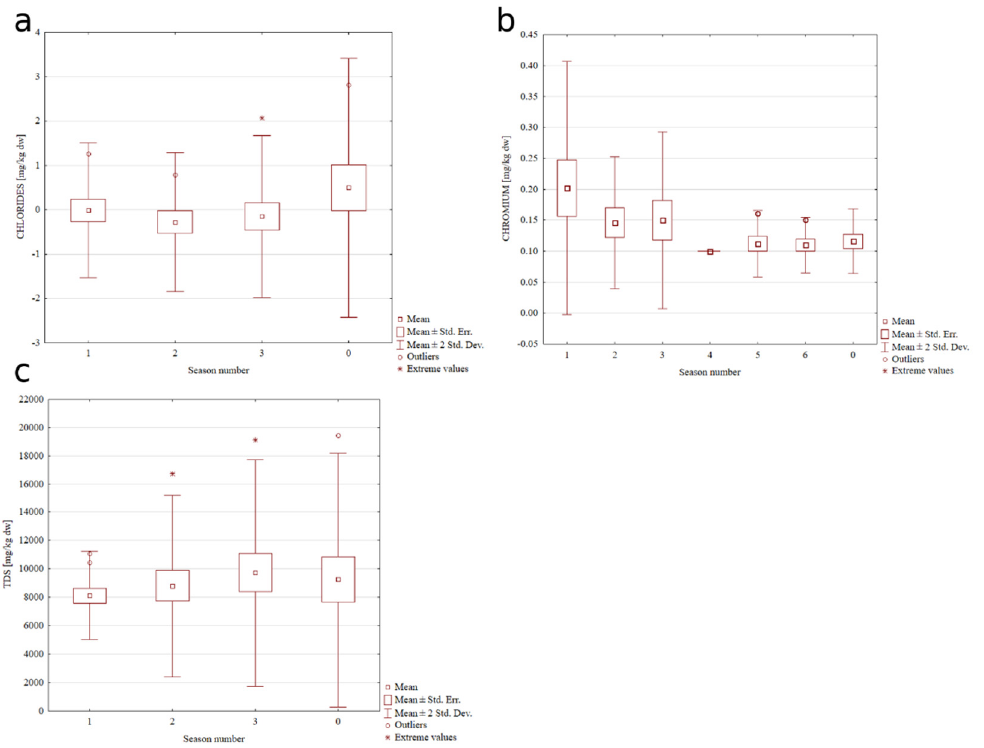
Figure 7. Box and whisker plot (( a ) chlorides, ( b ) chromium, ( c )